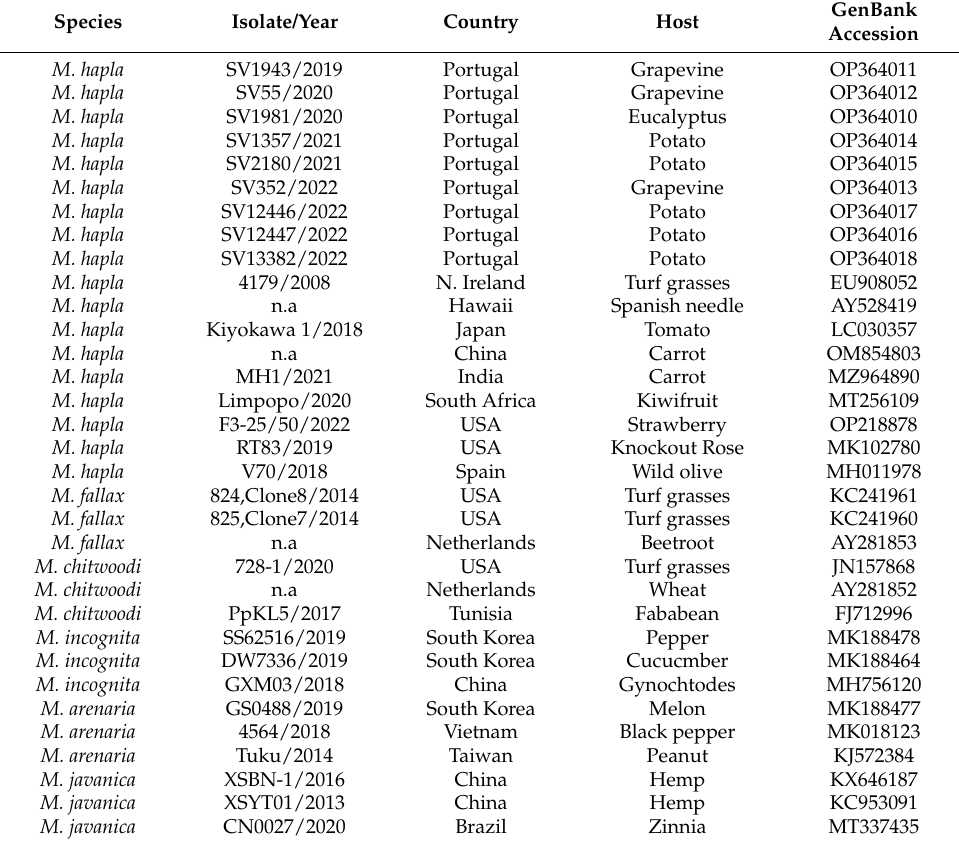
Figure 5. DNA amplification products obtained from isolates of Meloidogyne hapla using species- specific primers in multiplex (JMV1, JMV2 and JMVhapla). M: 100-bp DNA ladder (BIORON); Lanes 1–9: M. hapla . Positive controls: C-Mh: M. hapla ; C-Mc: M. chitwoodi ; C-Mf: M. fallax . Table 3. Details of isolates obtained in this study, and isolates representing species of Meloidogyne hapla retrieved from GenBank and used in phylogenetic analyses.